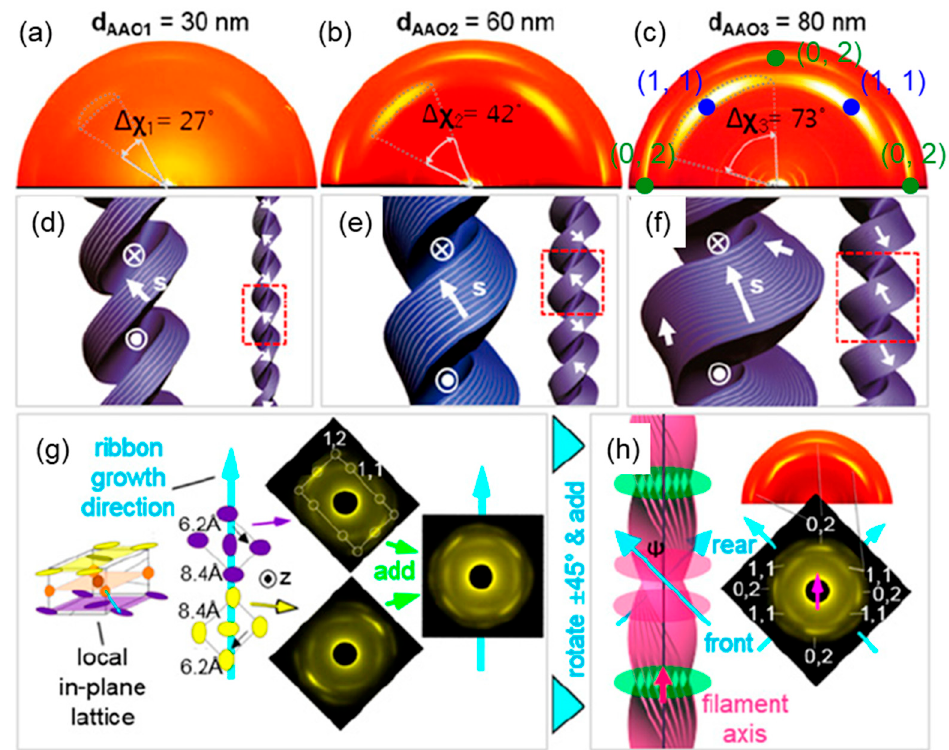
Figure 6. ( a ‒ c ) 2D-GIXD results of uniaxially aligned HNFs in each AAO pore with pore diameter (D p ) variation. d aao and Δχ refer to the D p of each AAO pore and the and the full width at half maximum (FWHM) value of azimuthal angle deviation in (1,1) peak. ( d ‒ f ) 3D model of individual HNF in each pore. s represents the normal layer direction of the smectic layer. ( g ) Herringbone-like lattice made of bent-core LC molecules and their 2D diffraction patterns. ( h ) Final diffraction pattern of vertically oriented HNFs in AAO film. Reprinted with permission from [35], Copyright 2014, National Academy of Sciences.